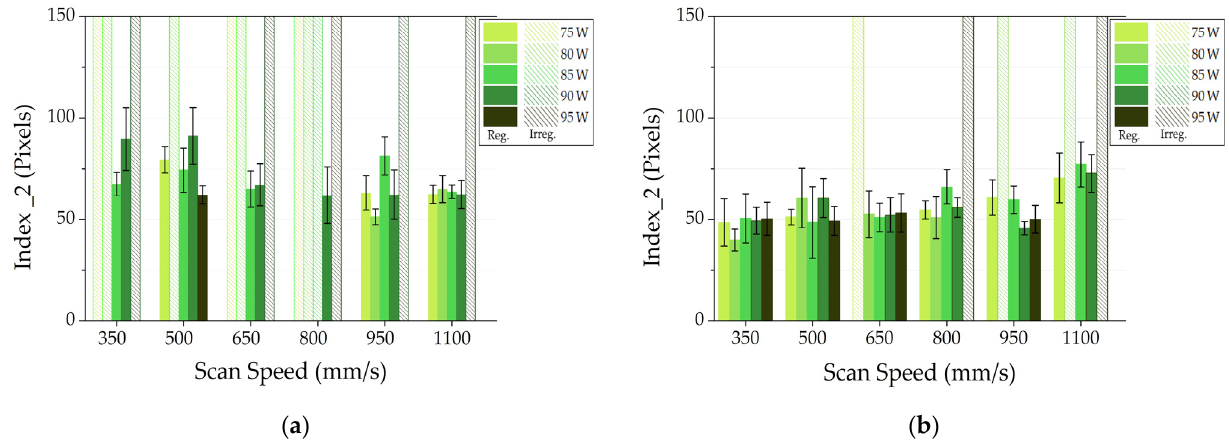
Figure 7. Index 2 for AlSi10Mg jobs built with a layer thickness of 20 μ m ( a ) or 25 μ m ( b ).